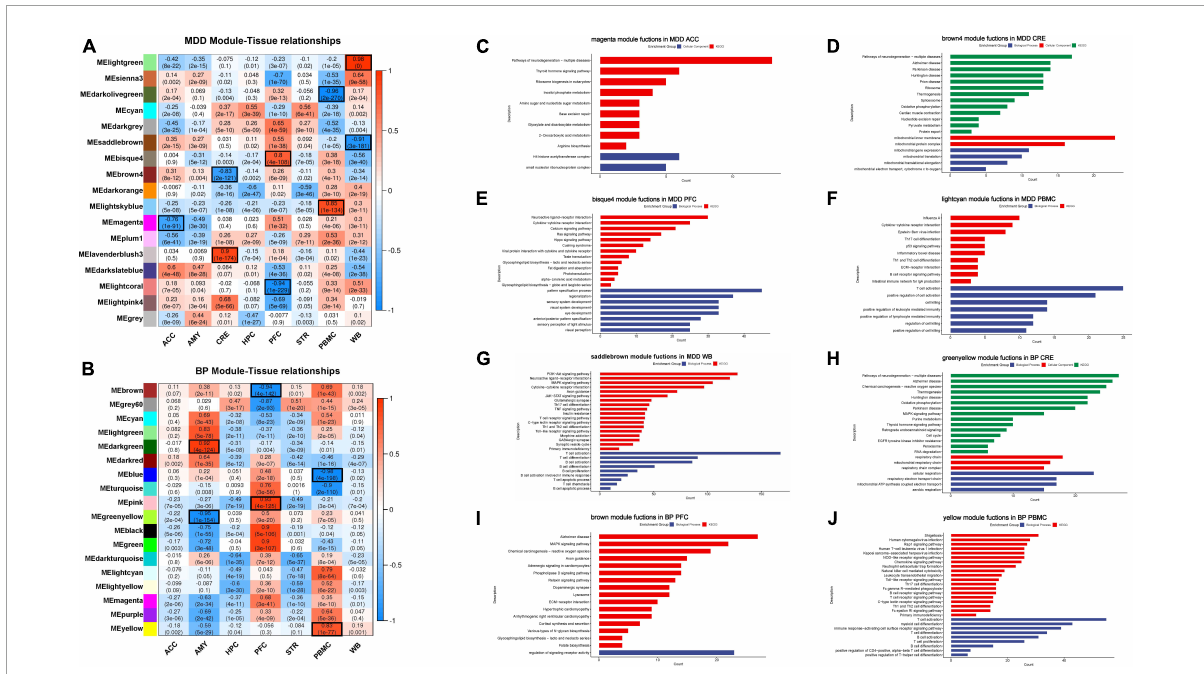
FIGURE2 (A,B) Correlation and p -value between co-expression network modules and tissues in MDD- and BP-. Correlation coefficient and p -value are shown, and we defined the absolute correlation coefficient > 0.6 and p -value < 0.05 as the tissue-specific module. (C–J) GO and KEGG analysis results of certain tissue-specific modules. We focus on the tissue-specific module, the results of functional enrichment analysis showed that ACC is related to histone modification, CRE is participant in mitochondrial and ribosome function, PFC is related to cognition, and blood tissue have a primary role in immune